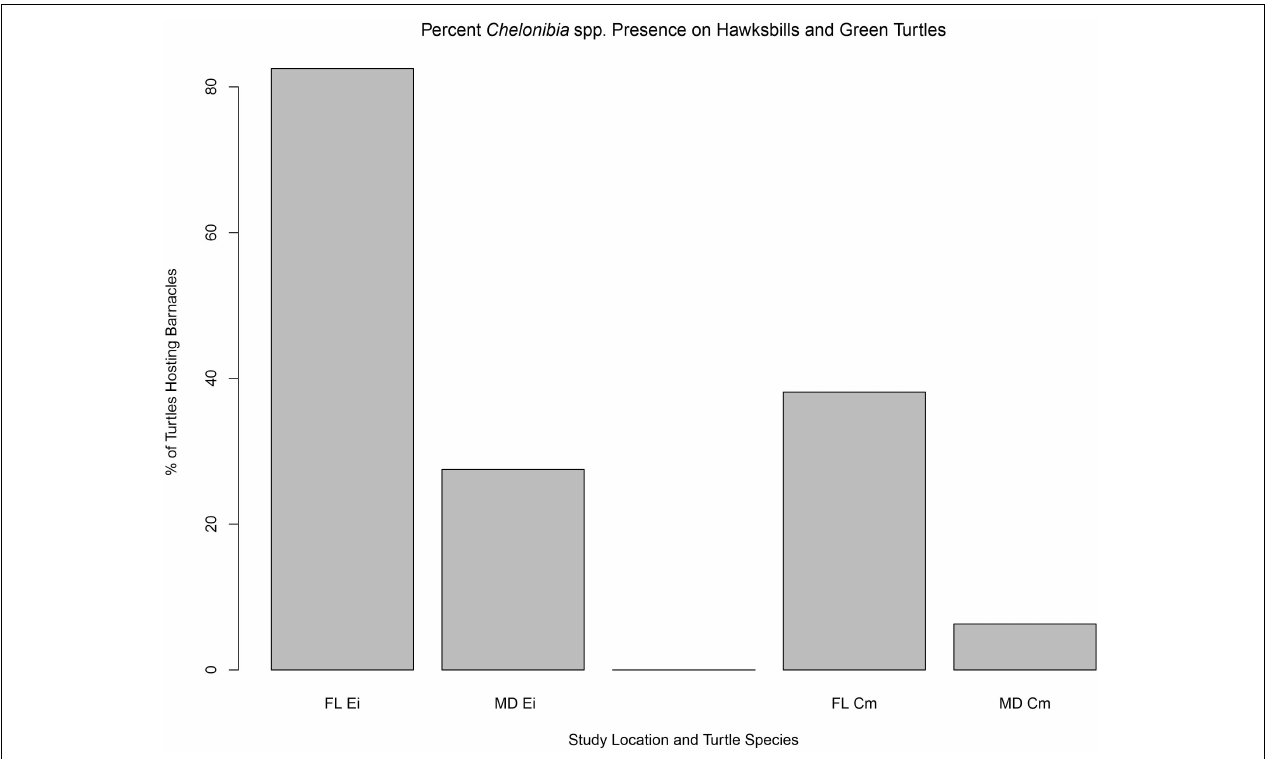
FIGURE 6 | Percent occurrence of Chelonibia barnacles per host species per geographic location, for hawksbill (Ei) and green turtles (Cm) in Florida (FL) and Madagascar (MD). At both locations, hawksbill turtles hosted the barnacle C. caretta only and green turtles only C. testudinaria .